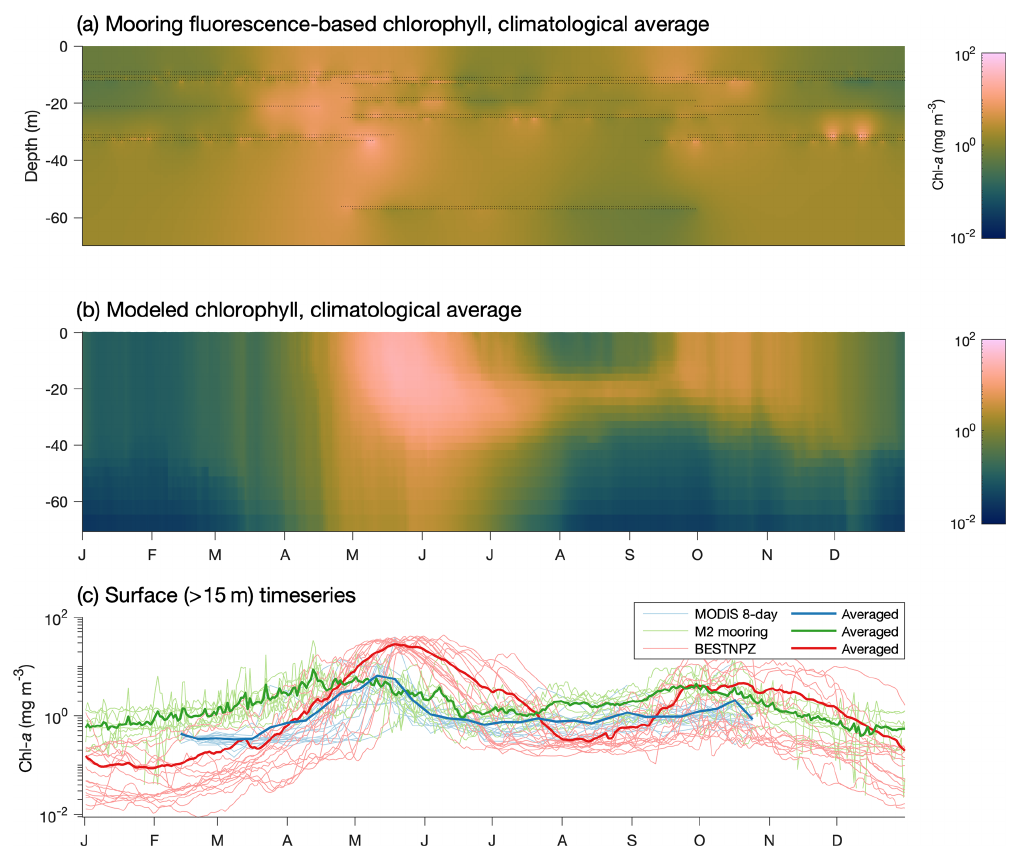
Figure 11. (a) Fluorescence-derived chlorophyll measurements at the M2 mooring location. Black dots indicate individual measurements, while the shaded values indicate estimates using a spring model interpolant (D’Errico, 2016). (b) Modeled chlorophyll extracted at the M2 mooring location over the same time period as the mooring data (2004–2017). (c) Surface-only climatological time series at the M2 lo- cation from mooring-based measurements, via satellite (within a 1 ◦ box around the M2 location derived from MODIS Aqua OCI algorithm 4km 8d average images) and in the BESTNPZ